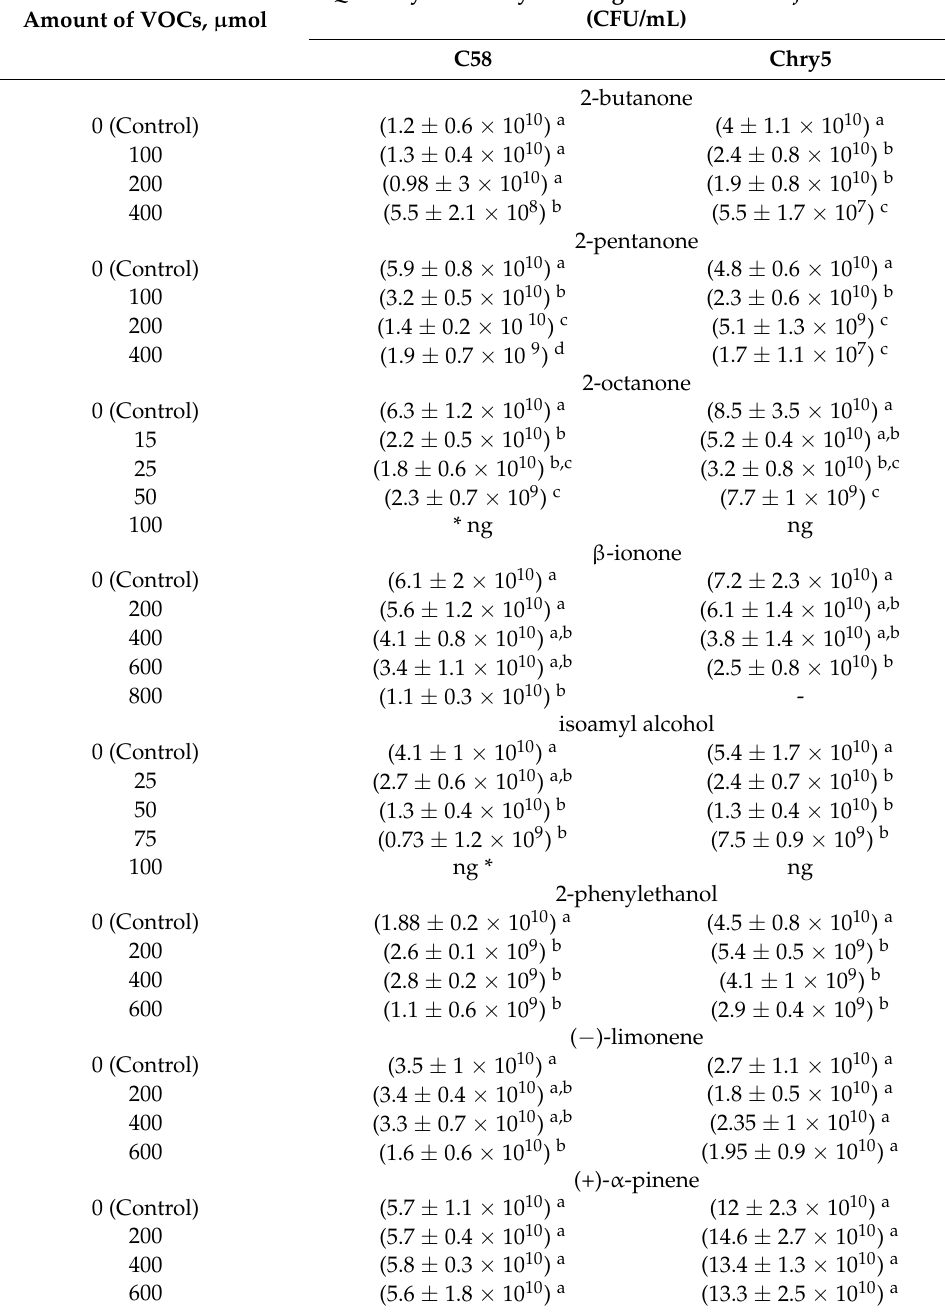
Amount of VOCs, µ